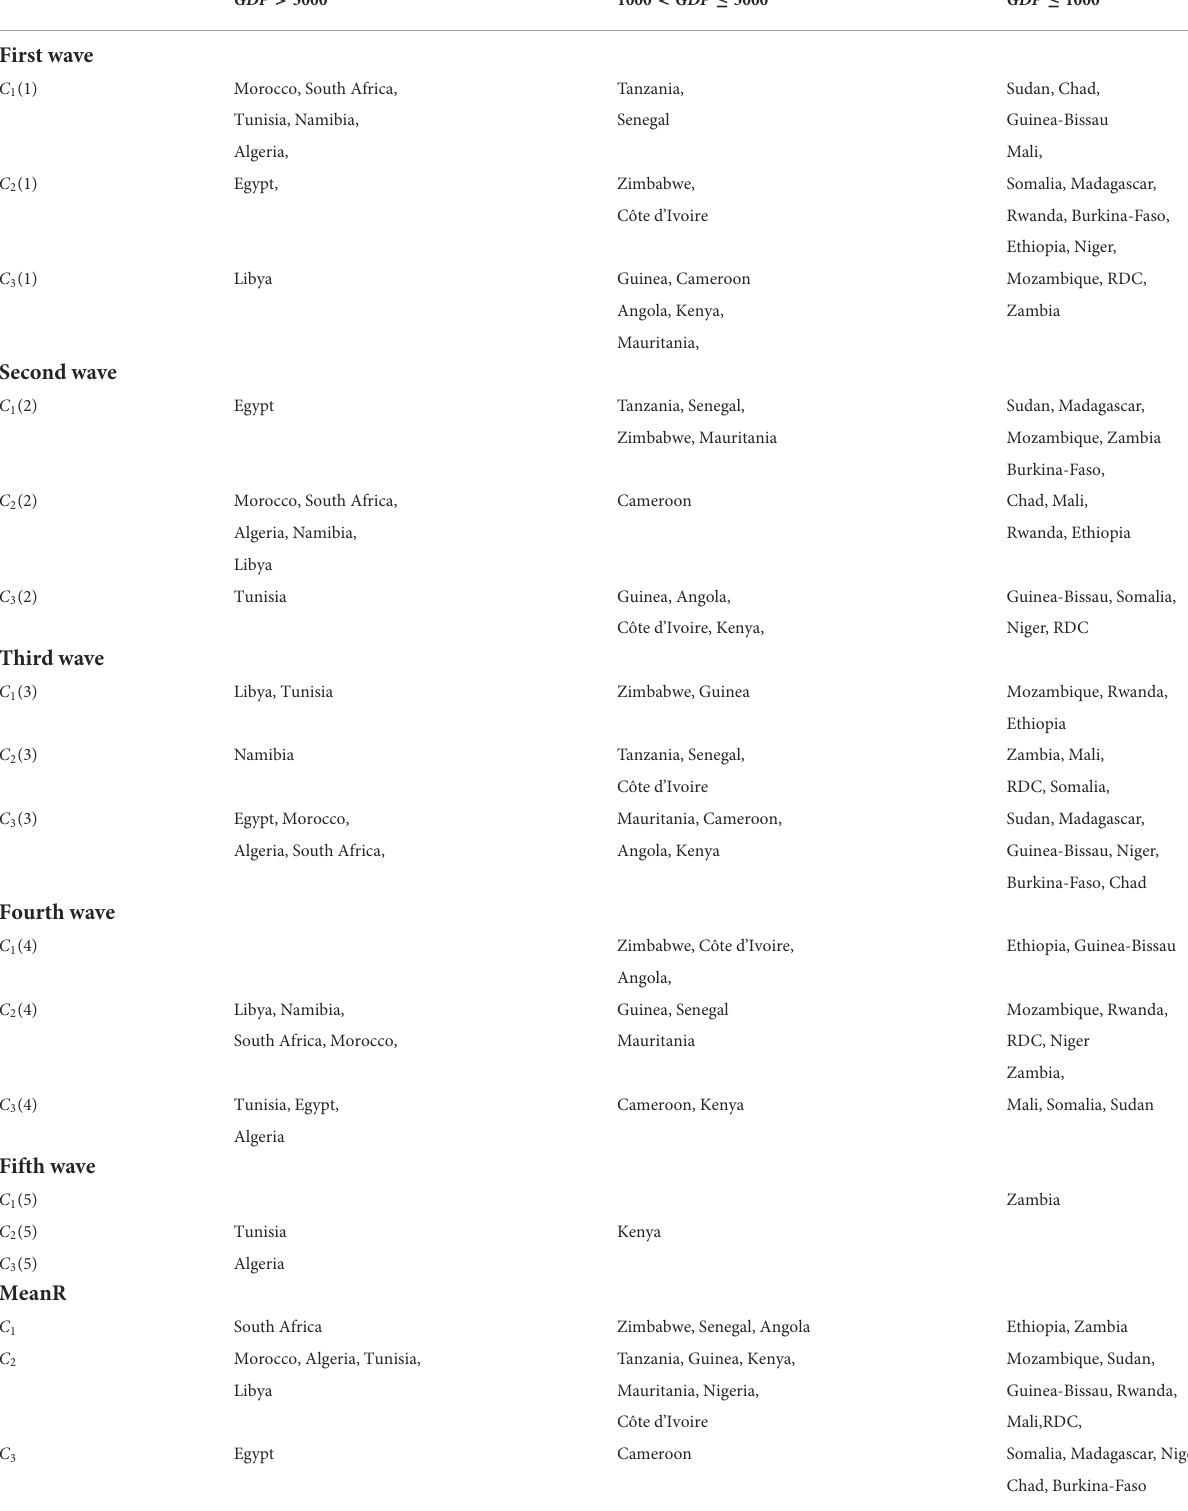
TABLE 5 Distribution of the countries between classes waves of R 0 and GDP (in US $